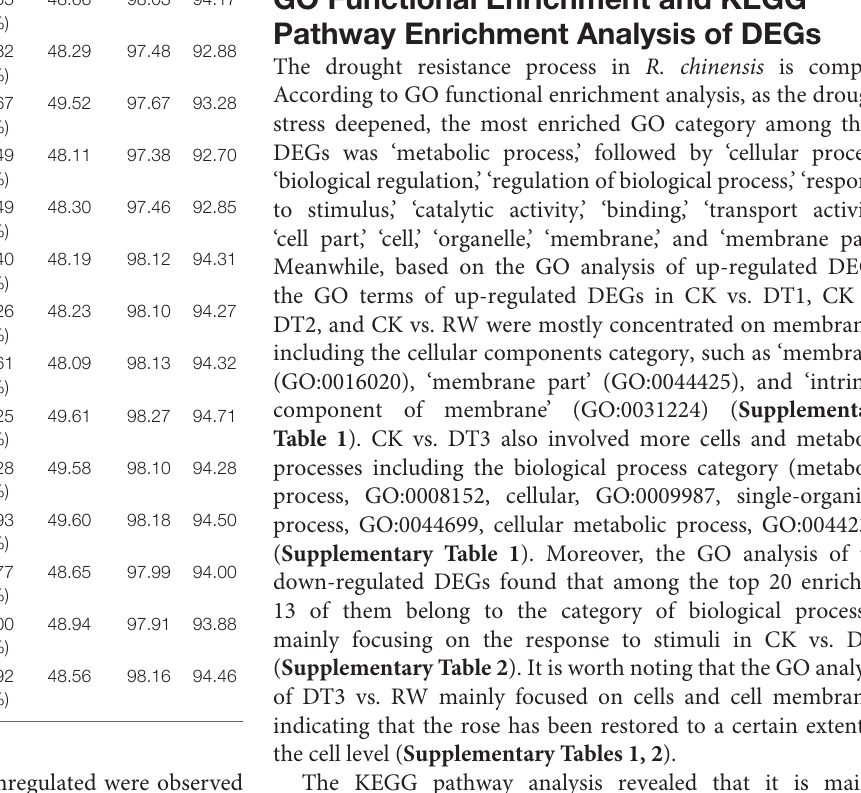
Frontiers in Genetics |